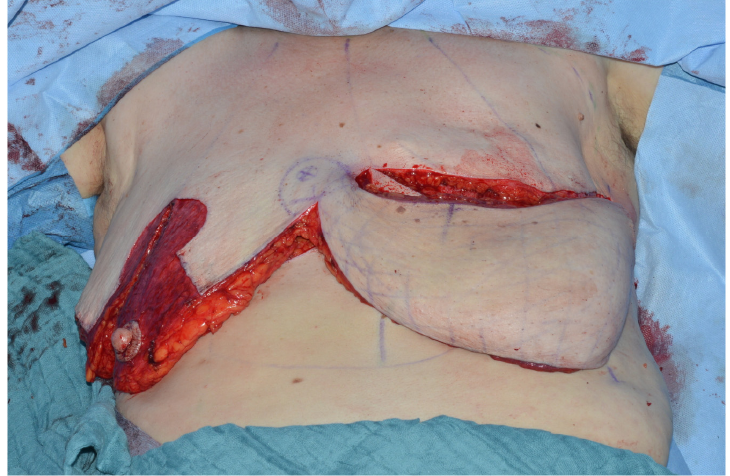
Figure 5. Rotation of the inferior part anticlockwise in a propeller fashion to the contralateral side.